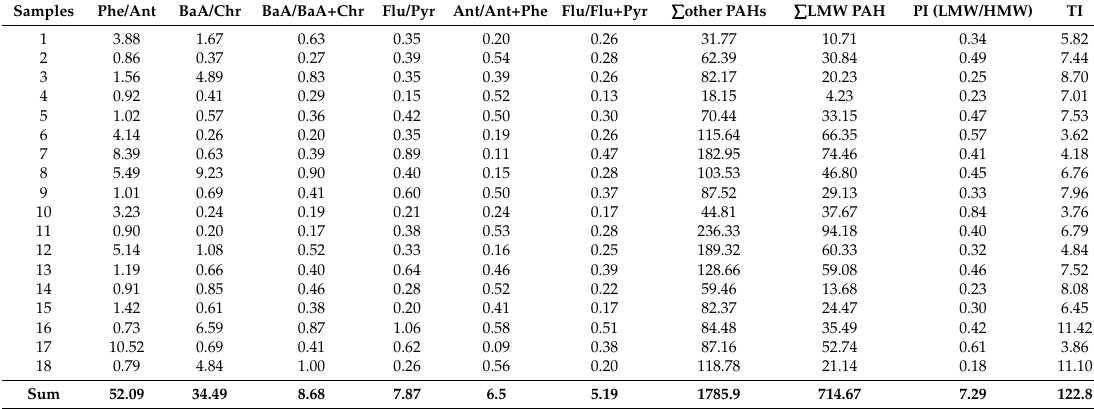
Table 5. The diagnostic ratios, pyrogenic index (PI), and total index (TI) of the investigated